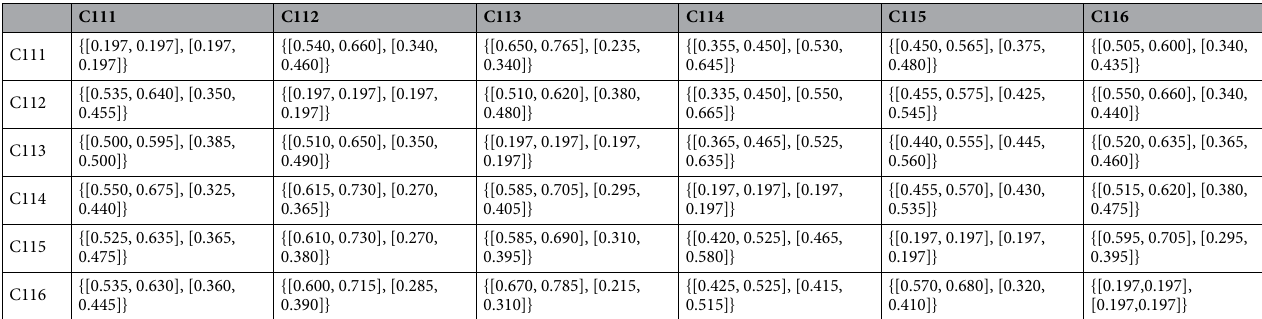
Table 5. The compromise pairwise comparison matrix of